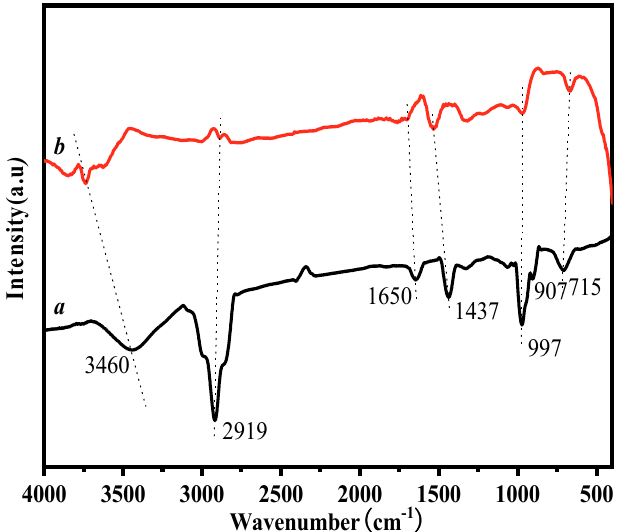
Figure 4. FT − IR spectra of HTPB ( a ) and HTPB/nNi ( b ).